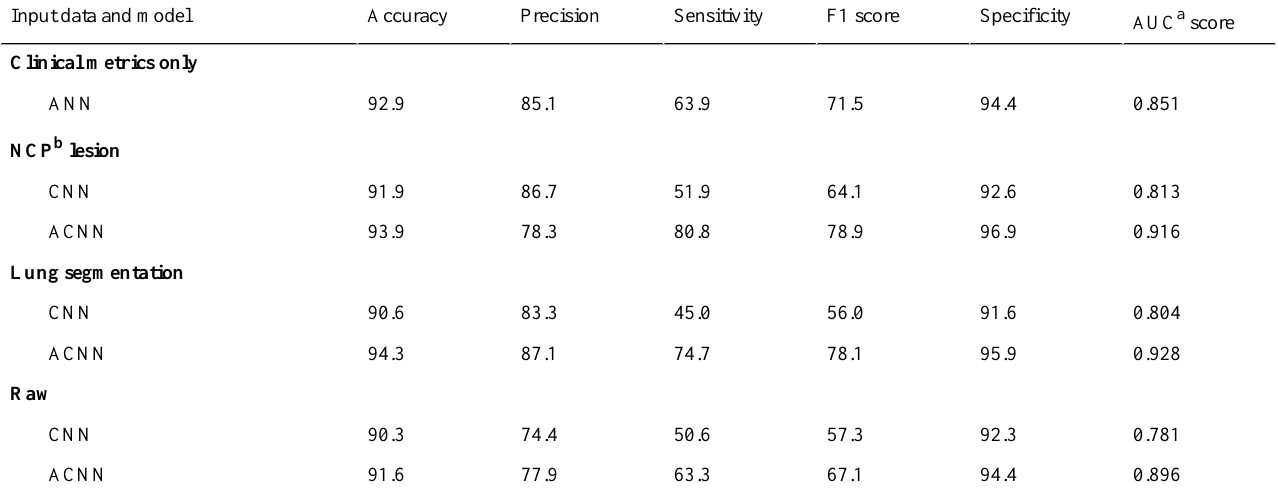
Table 2. Performances of artificial neural network (ANN), convolutional neural network (CNN), and artificial convolutional neural network (ACNN) models for predictions of event versus event-free cases.